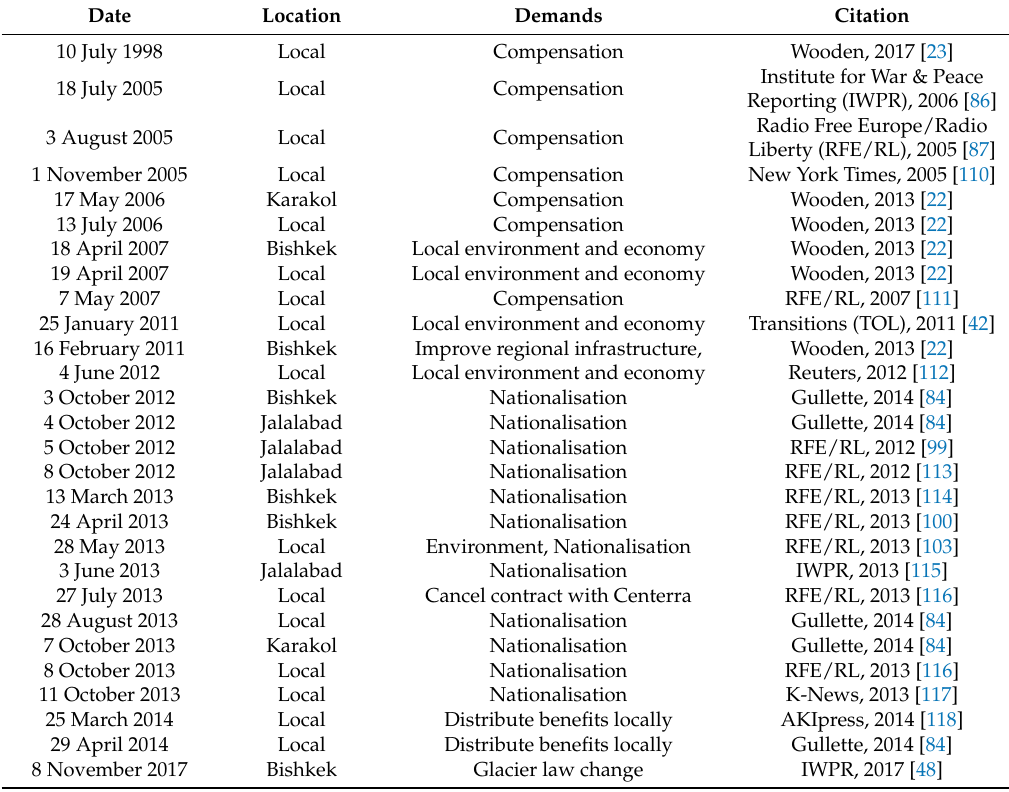
Table 2. Location and demands of reported Kumtor